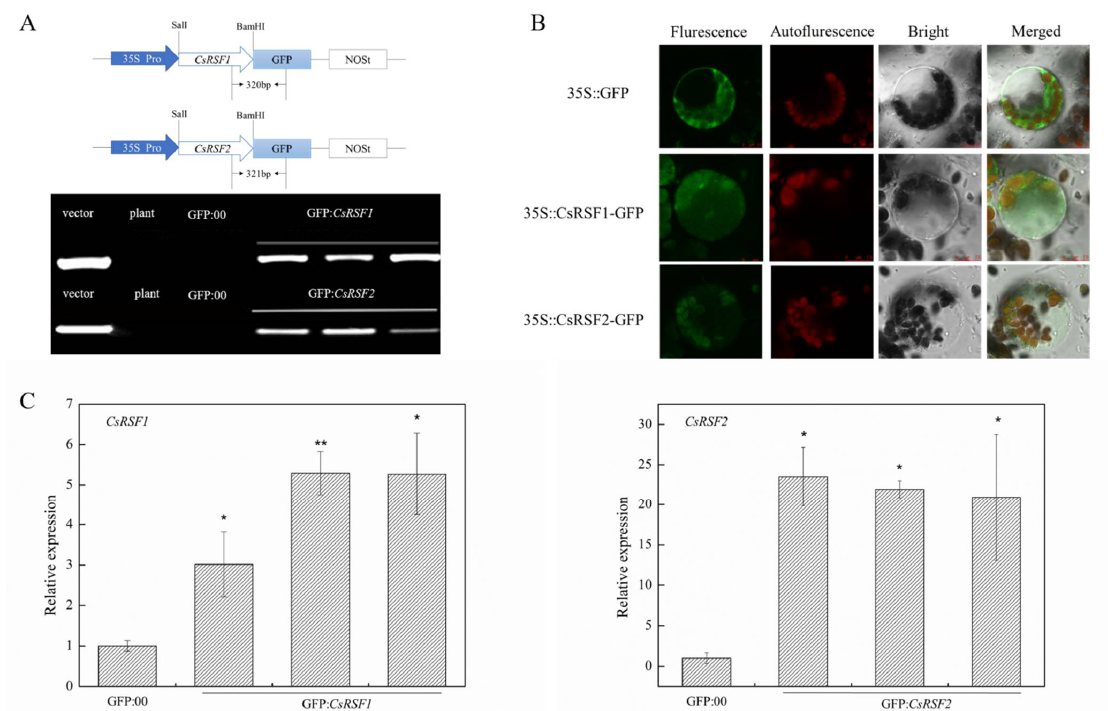
Figure 7. Identification of CsRSF1 / CsRSF2 -overexpressing cucumber plants. ( A ) Schematic of the CsRSF1 / CsRSF2 -GFP constructs. CsRSF1 and CsRSF2 were between 35S Pro and GFP protein, and chimeric PCR identifications of CsRSF1 and CsRSF2 genetically modified cucumber were successful. Vector, recombinant plasmid; plant, non-transgenic cucumber; GFP: 00, empty vector; GFP: CsRSF1 , CsRSF1 -transient overexpressing in cucumbers; GFP: CsRSF2 , CsRSF2 -transient overexpressing in cucumbers. ( B ) Luminescence signal identification for transient overexpressing cucumber cotyledons. Bar = 10 µm. ( C ) CsRSF1 / CsRSF2 -overexpressing were identified in transgenic plants by qRT–PCR. Data are means ± standard deviations (SD) from three independent experiments, and each column represents a sample containing three cucumber cotyledons from different plants. Expression analysis of candidate genes using the 2 −ΔΔ C t method. The asterisks indicated a significant difference (Student’s t -test, * p < 0.05 or ** p <